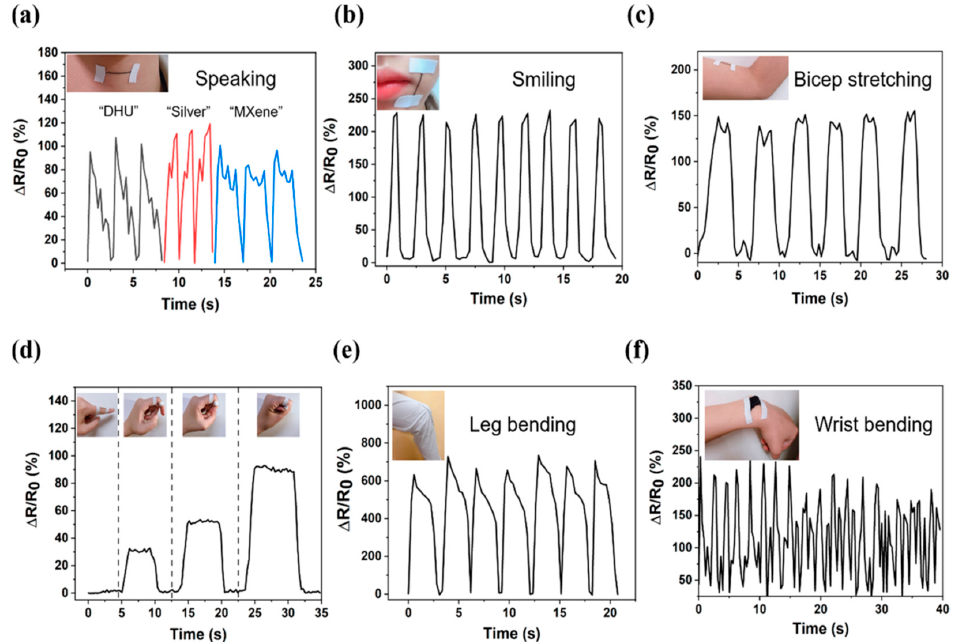
Figure 13. Monitoring of human motion using the nanocomposite MXene Silver (NMS) yarn strain sensor. ( a ) Speaking different words, ( b ) smiling, ( c ) bicep stretching, ( d ) finger bending, ( e ) leg bending, and ( f ) wrist bending. Reprinted with permission from Ref. [109]. Copyright 2019, Ameri-